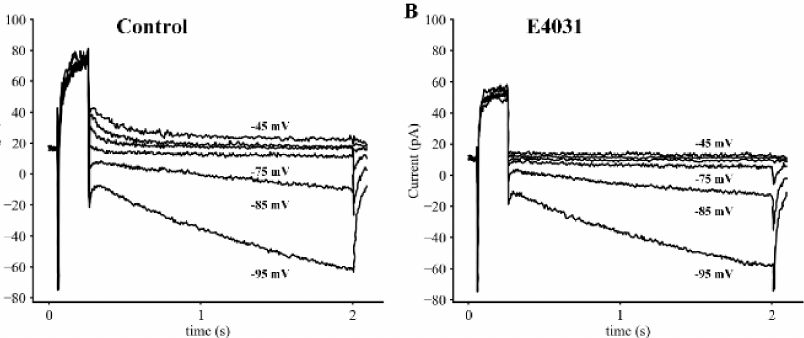
Figure 3. Illustration of the K + Selectivity of HERG in Primary Pacemaker Myocytes from Adult Mouse SAN. The six sets of superimposed traces in both Panels ( A , B ) illustrate the deactivation kinetics and reversal potential for the HERG K + current in adult mouse SAN cells. In these paired experiments, 100 ms voltage clamp depolarizations from a holding potential of − 60 mV to +5 mV were applied at 0.1 Hz to strongly activate HERG and immediately after each depolarization the membrane potential was returned for 1.9 s to membrane potentials ranging between − 45 and − 95 mV. Note from the records in Panel ( A ) that the deactivation tail reversed between − 75 and − 85 mV. The records in Panel ( B ) were generated using an identical protocol to that utilized in Panel A beginning approximately three minutes after the application of 1.7 M E4031. This maneuver was done to separate the deactivation of HERG in the range of membrane potentials − 75 to − 95 mV from the activation of a separate current, I f . (see Results and